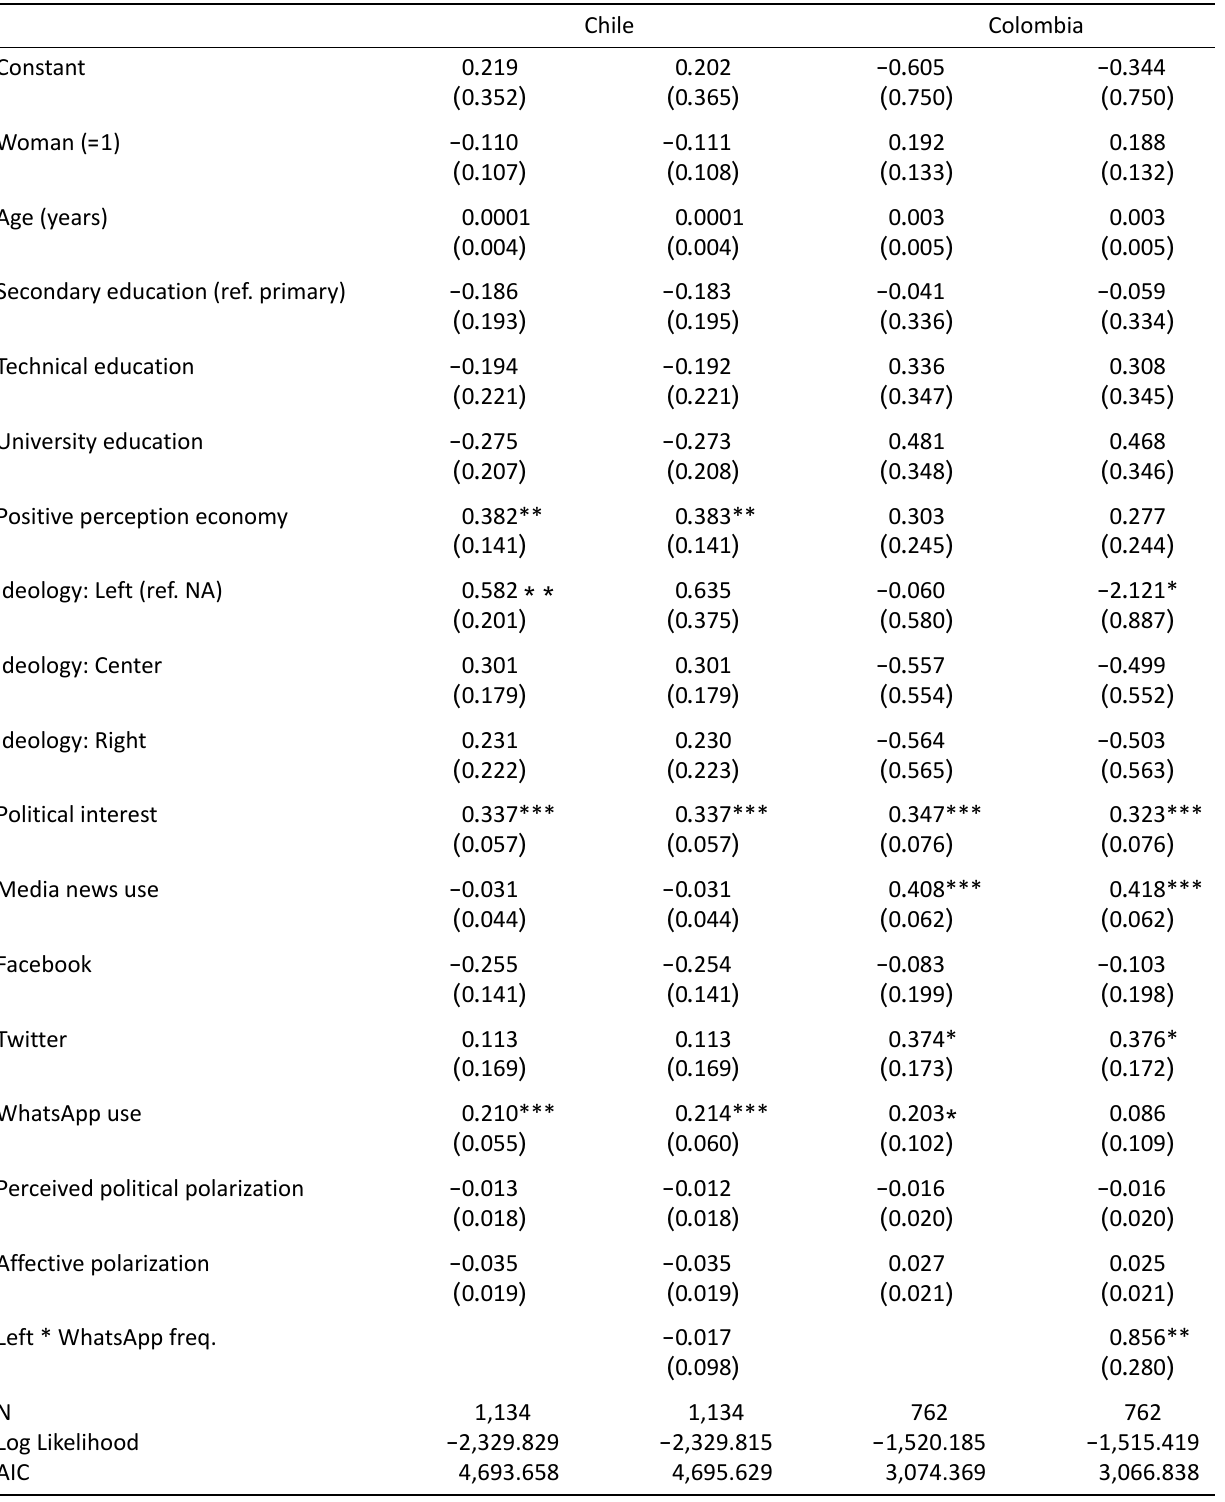
Table 5. Determinants of non‐conventional political